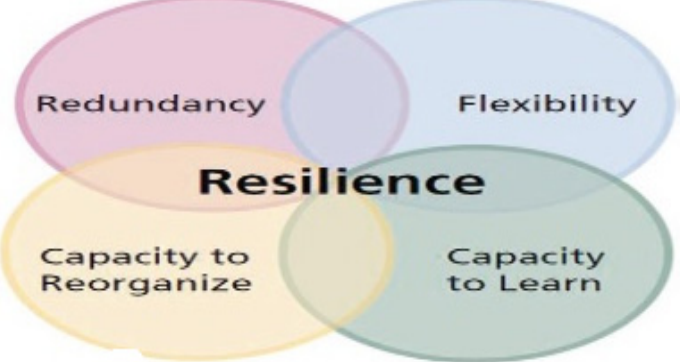
Figure 7. Elements of urban resilience, source, Melkunaite and Guay, [35].